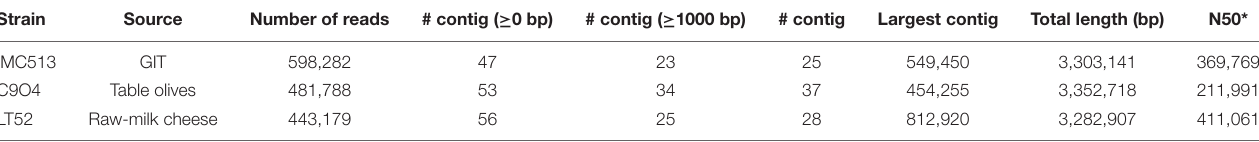
TABLE 1 | Genome assembly data after Nanopore and Illumina sequencing. Strain